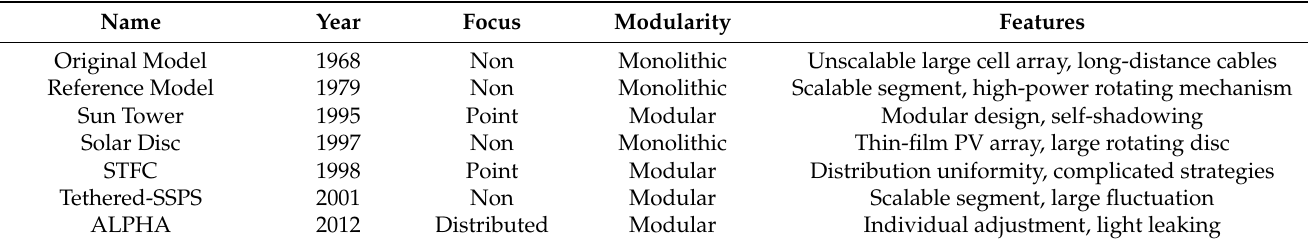
Table 1. Illustration of typical